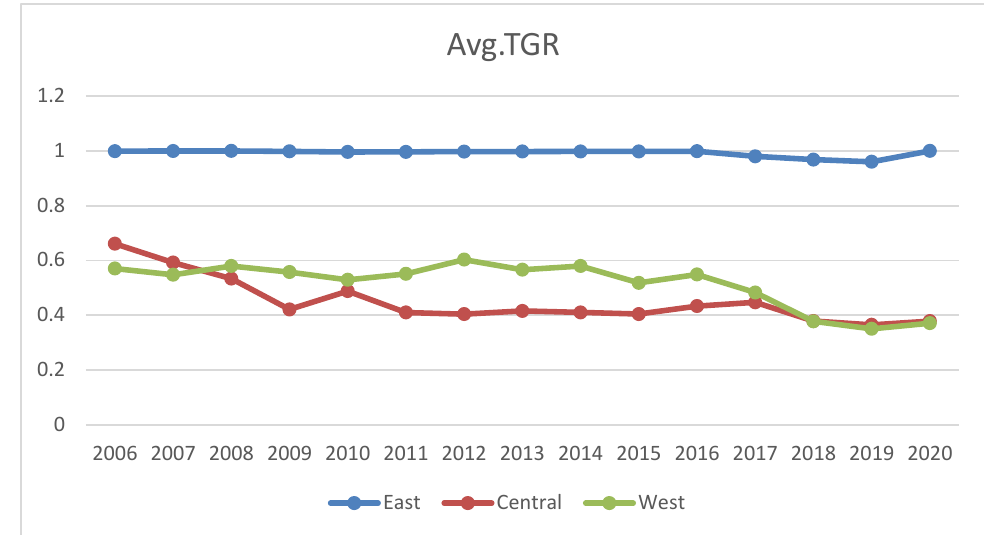
Figure 4. Technology gap ratio between three different Chinese regions (2006–2020).